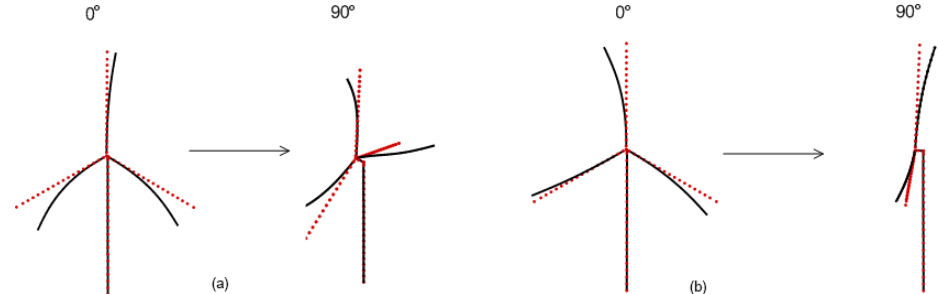
Figure 2. Mode shape alternation from 0 to 90 ◦ pitch for asymmetric edgewise modes (a) M6 and (b) M7. The red symbols indicate an undeformed state, and the black lines indicate a deformed